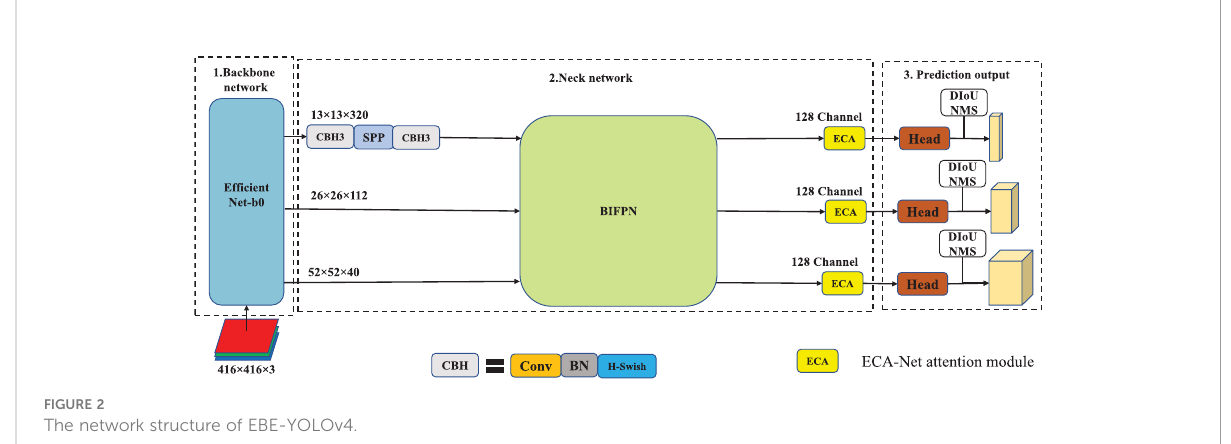
FIGURE 2 The network structure of